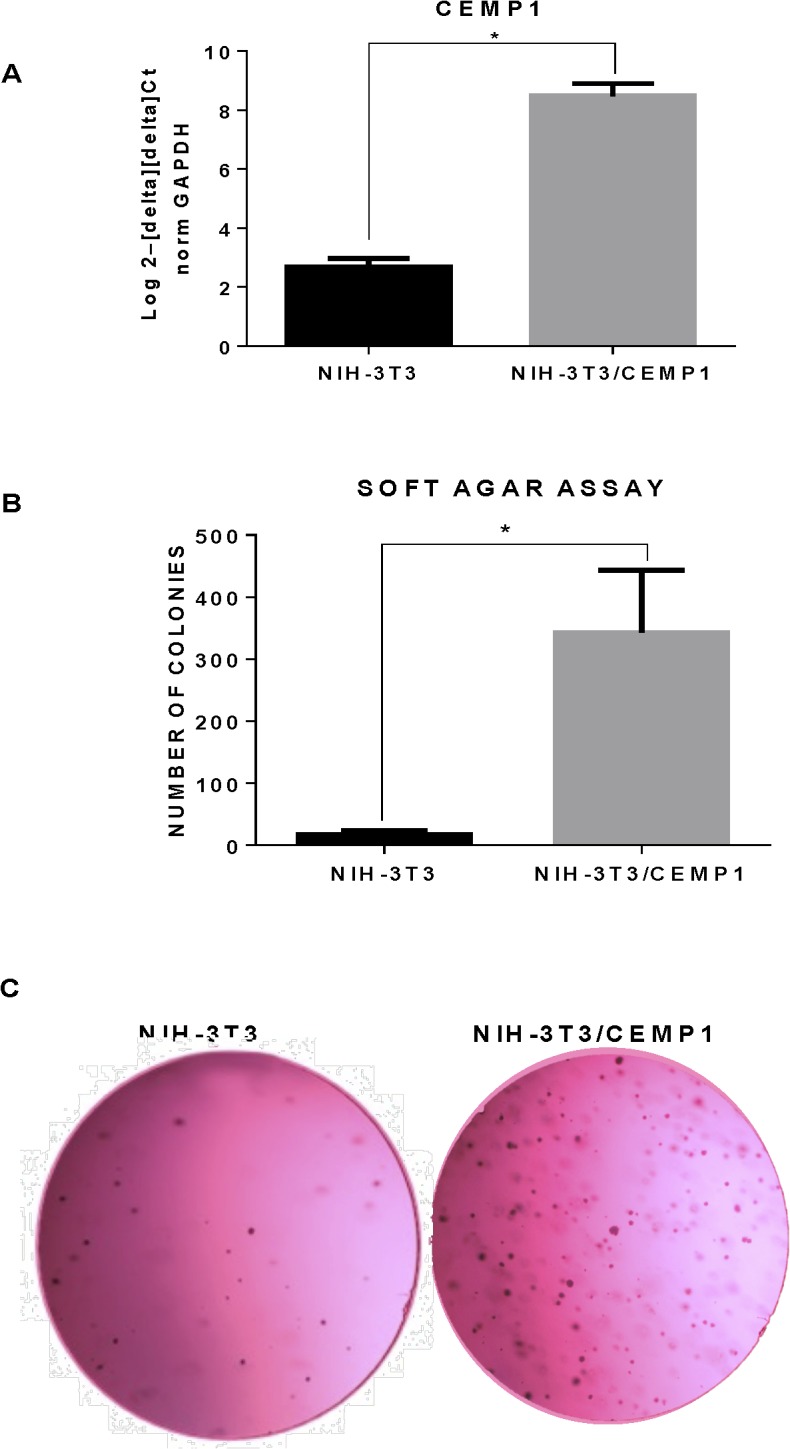
CEMP1 induces anchorage-independent growth in NIH-3T3cells.Cells were plated in a soft agar assay and the number of colonies was evaluated 21 days after the seeding. RT-qPCR supported overexpression of CEMP1 in NIH-3T3 in experimental group (A).Representative plates of NIH-3T3 and NIH-3T3 /CEMP are presented. All soft agar assays were performed in triplicates, and the mean ± standard deviations are presented (B and C).